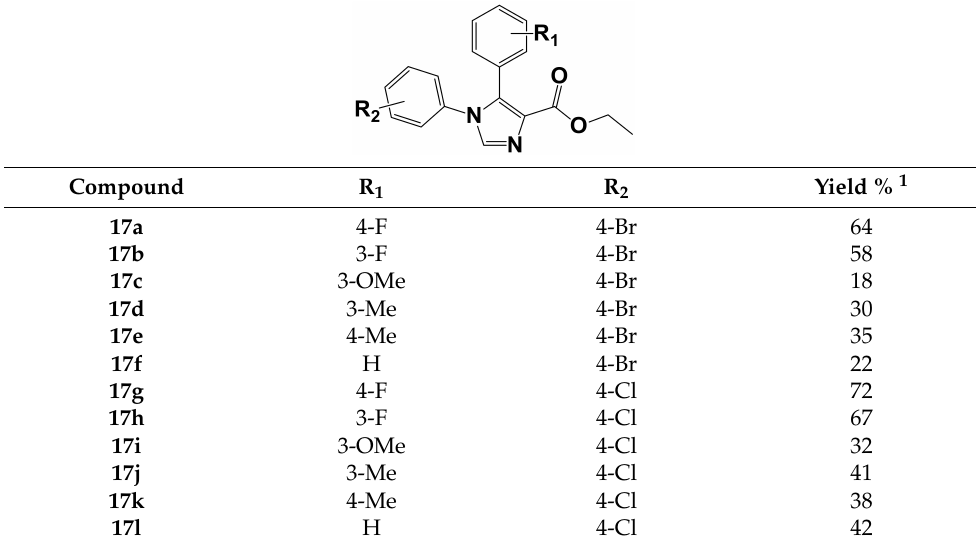
Table 1. Isolated yields of ethyl 1,5-diaryl-1 H -imidazole-4-carboxylates 17a – l